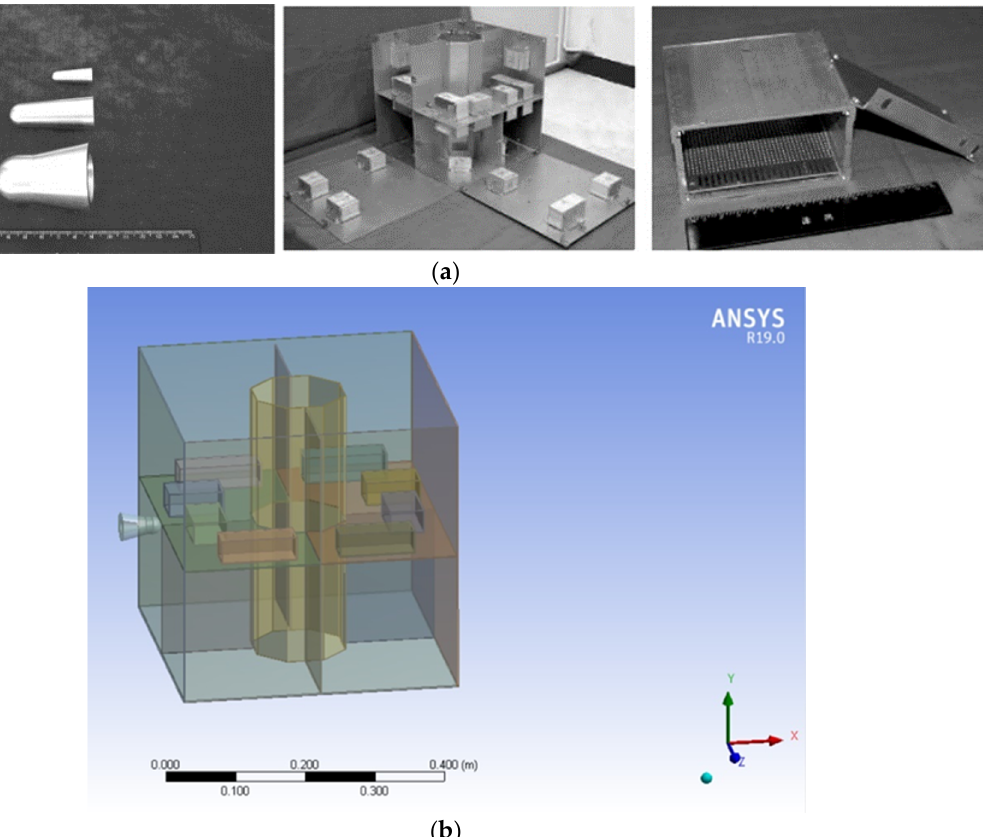
Figure 24. Schematic diagram of physical objects and simulation models of the simulated complex satellite structure and projectile. ( a ) Projectile, simulated complex satellite structure, and electronic box; ( b ) schematic diagram of the simulation structures of the projectile and simulated complex satellite